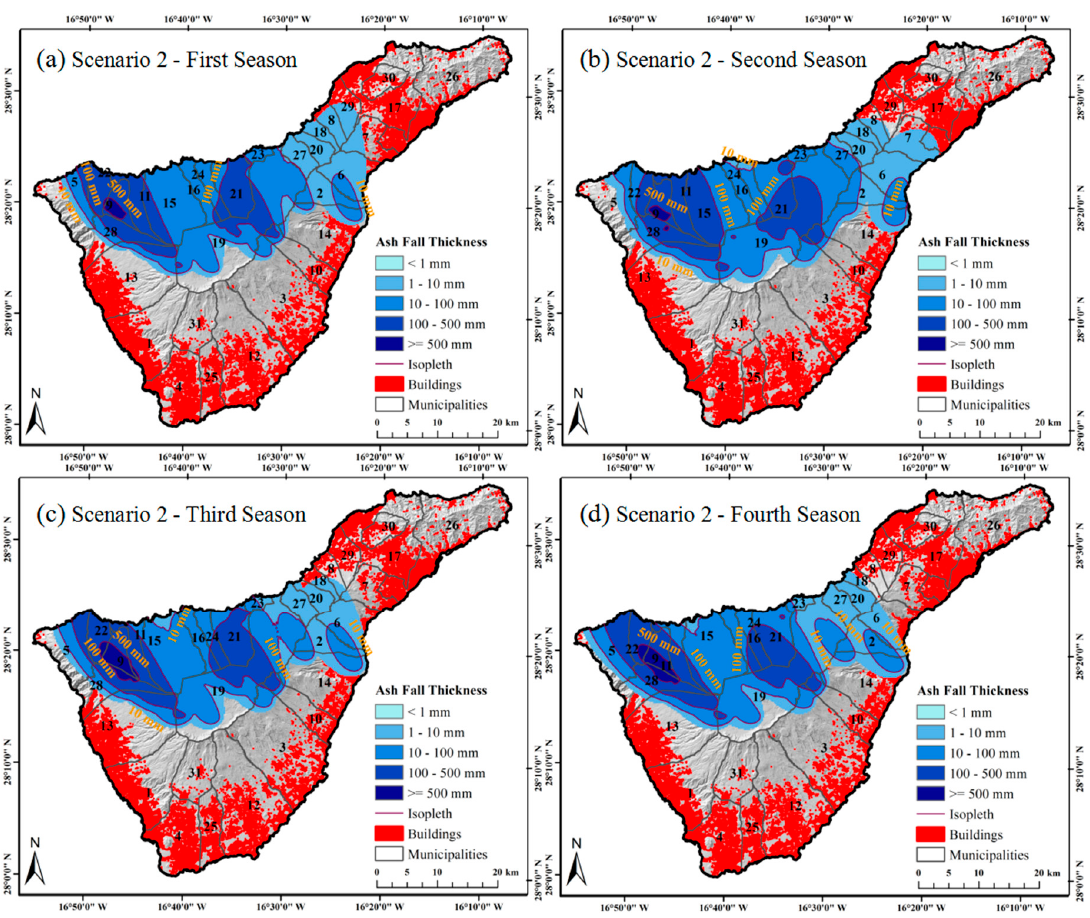
Figure 9. The distribution of simulated ash fall in Scenario 2. ( a ) First season; ( b ) second season; ( c ) third season; ( d ) fourth season.